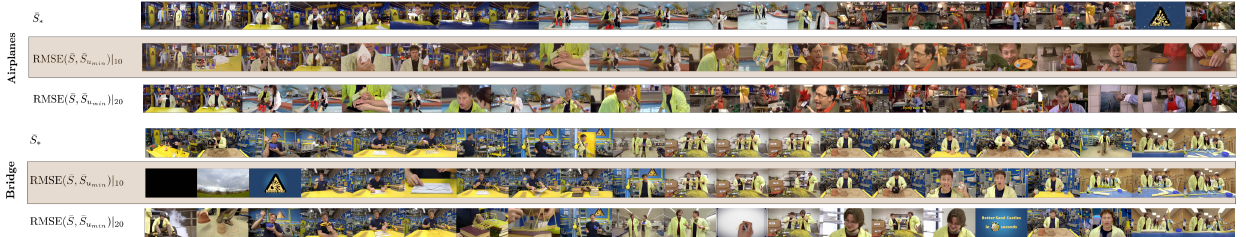
Figure 4. Summarization of videos using the baseline based on the Signature Transform in comparison to the summarization using text-conditioned object detection. RMSE ( ¯ S , ¯ S u and ¯ S summaries for two videos of the introduced dataset. The best summary among the three, ∗ according to the metric, is